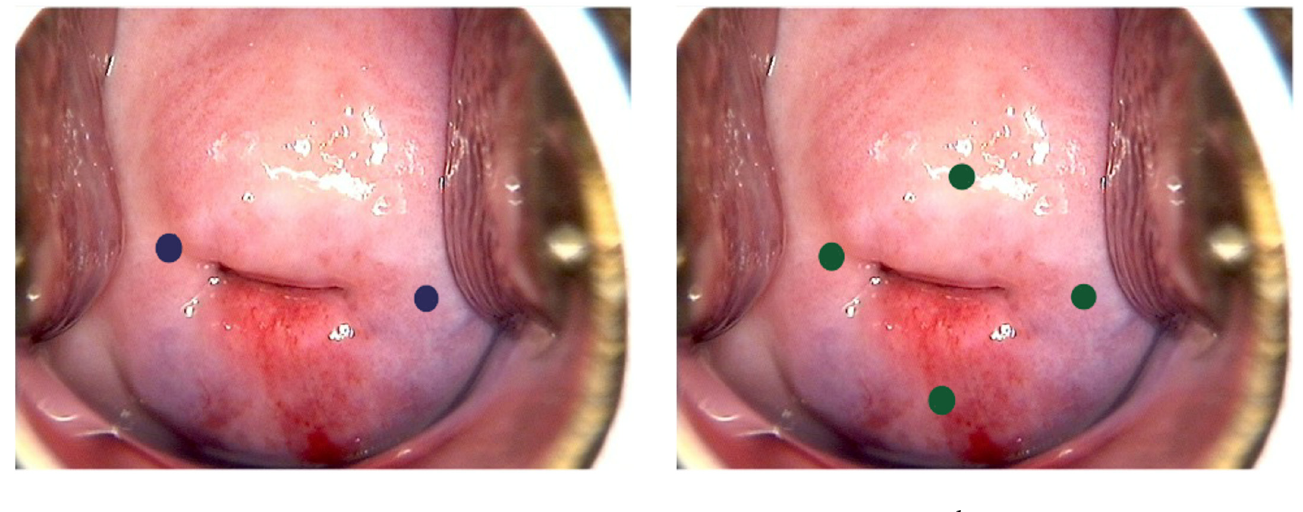
a b Figure 2. Injection of tracer at the cervix. Using ICG as example, 0.5–1 mL can be injected each su- perficially (1–3 mm at submucosa) and deeply (1–2 cm at stroma) at 3 and 9 o’ clock (blue dots) ( a